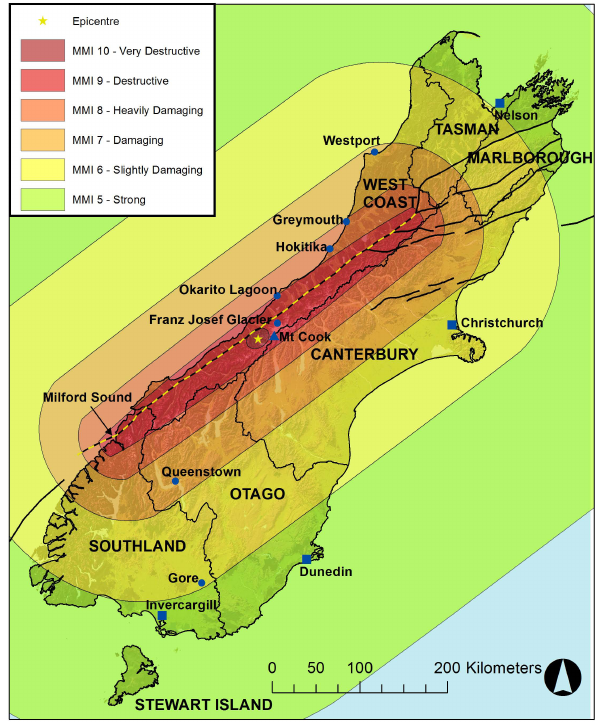
Fig. 5. Isoseismal model for a M w = 8 . 0 earthquake occurring on the central segment of the Alpine Fault. Based on the isoseismal models of Smith (1978), produced by N. Pondard of GNS Science at the authors request. Black and Yellow dashed line shows expected rupture